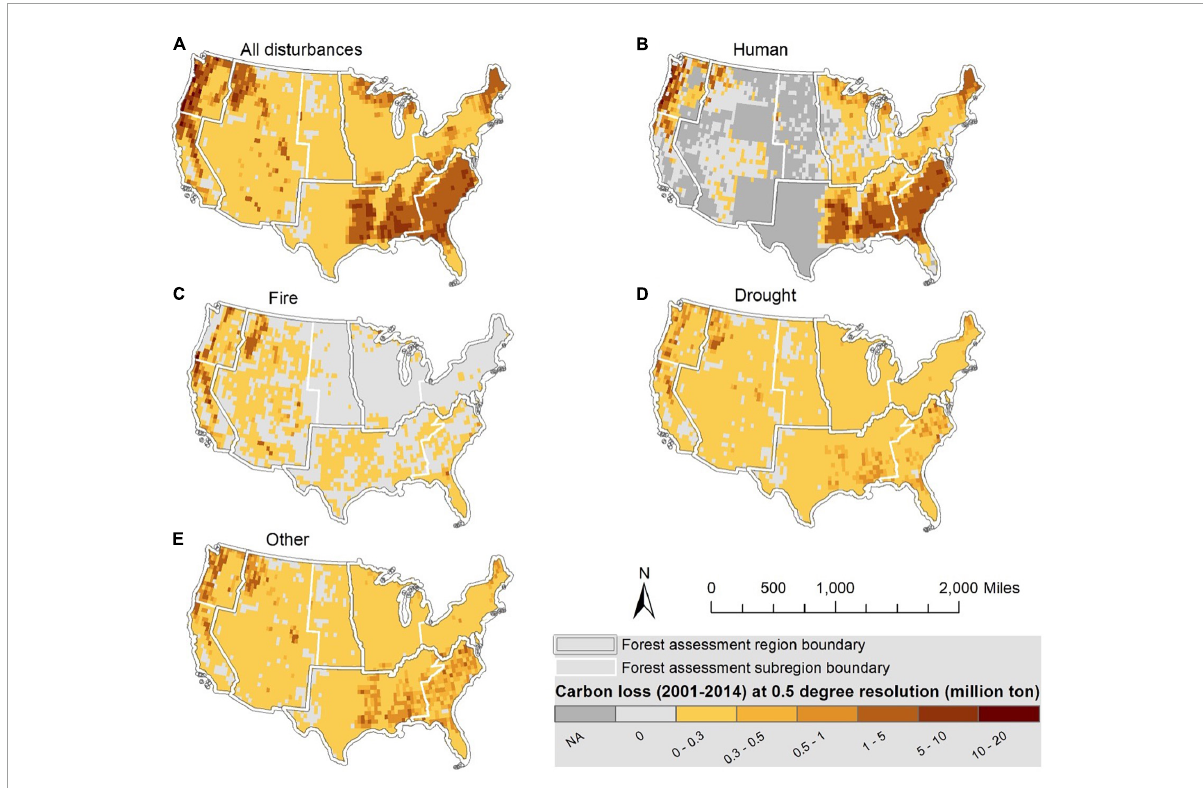
FIGURE5 Distribution of potential aboveground carbon stock loss/transfer from canopy trees in CONUS for 2000–2014. A disturbances (A) , anthropogenic disturbances (B) , fire disturbances (C) , drought associated disturbances (D) , and other disturbances (E)